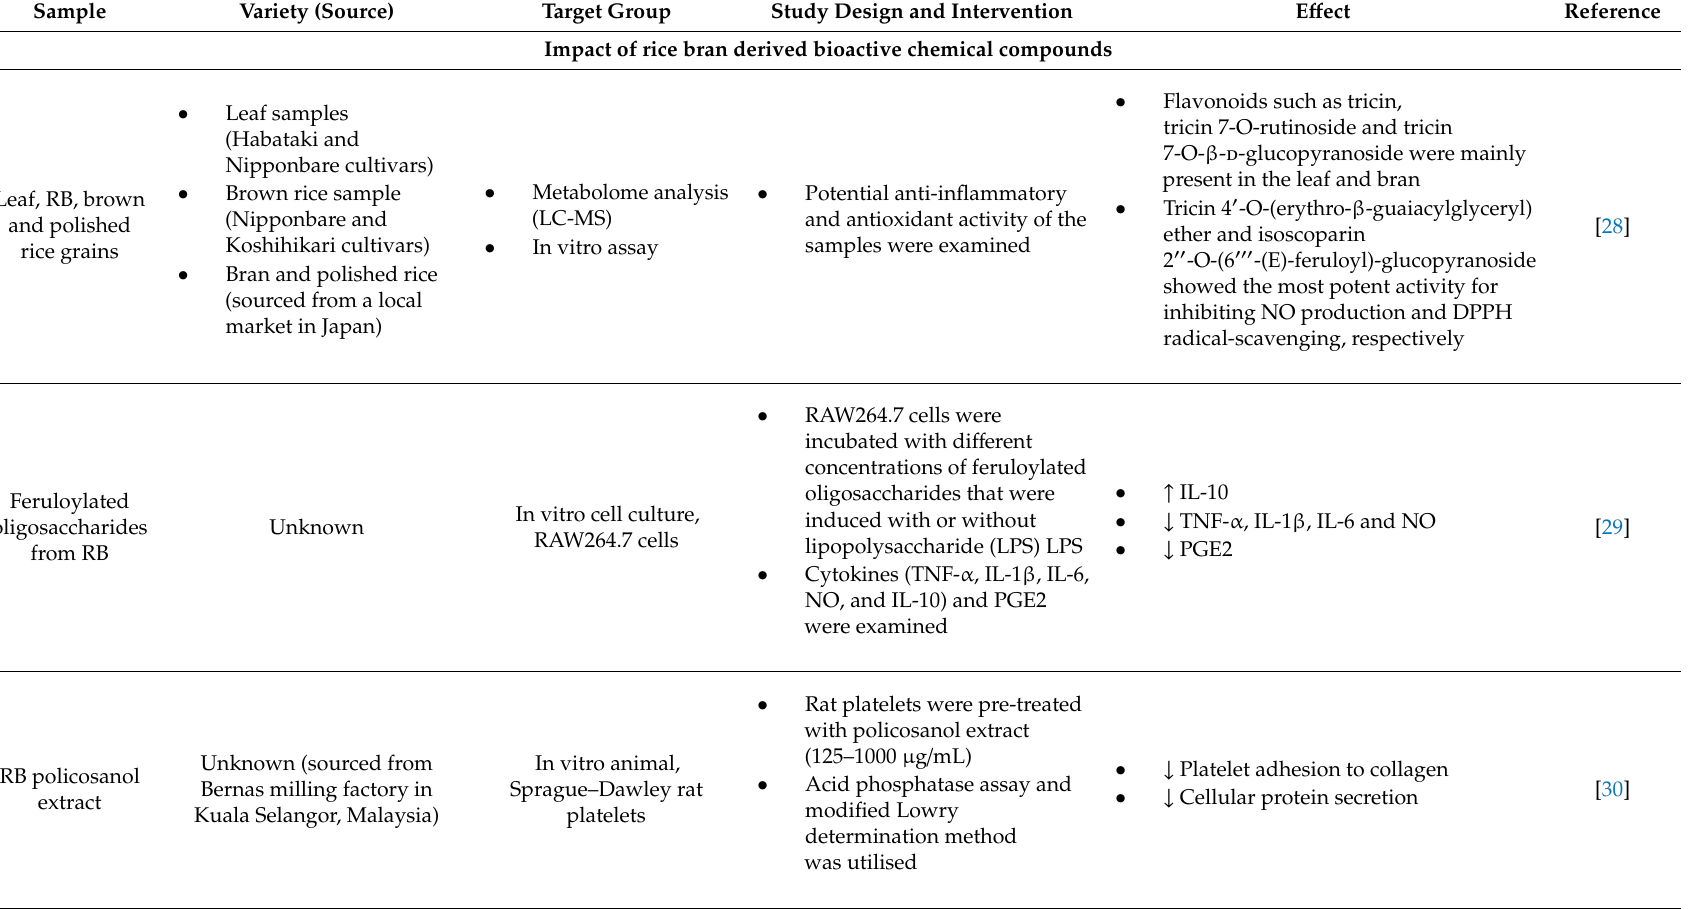
Table 1. In vitro and in vivo cardioprotective role of rice bran-derived bioactive